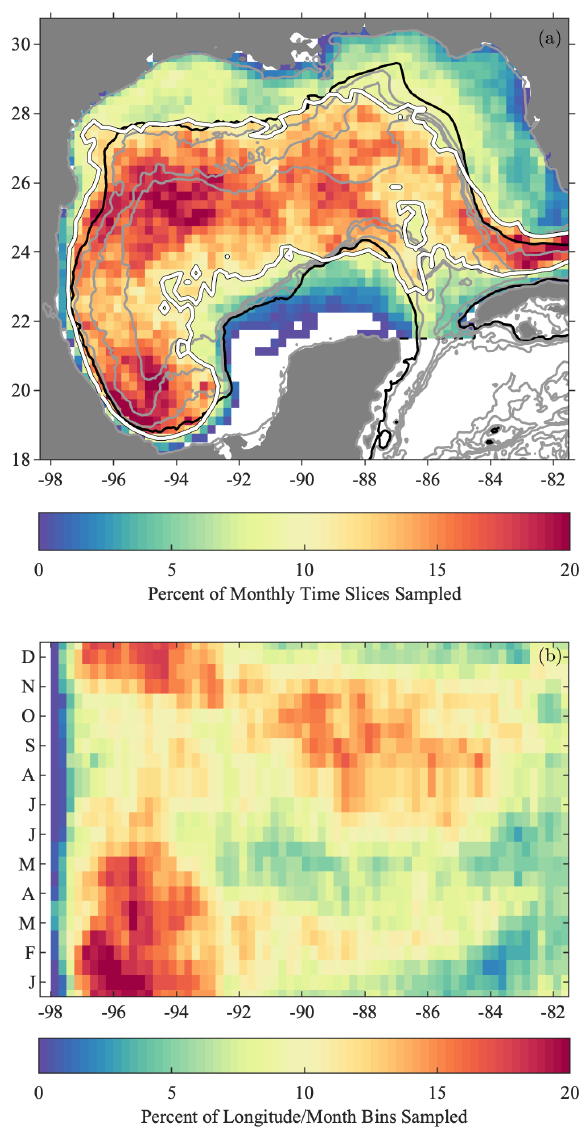
Figure 8. Sampling distributions for the GulfFlow-1 / 4 ◦ gridded dataset. The percent of time slices sampled in each 1 / 4 ◦ spatial bin is shown in (a) , while (b) shows the percent of possible longitude– month bins sampled, after summing over all years and all latitudes. The white line in (a) is the 10% sampling contour. In (b) , the bins are again 1 / 4 ◦ wide in longitude and are of monthly duration with semimonthly spacing in